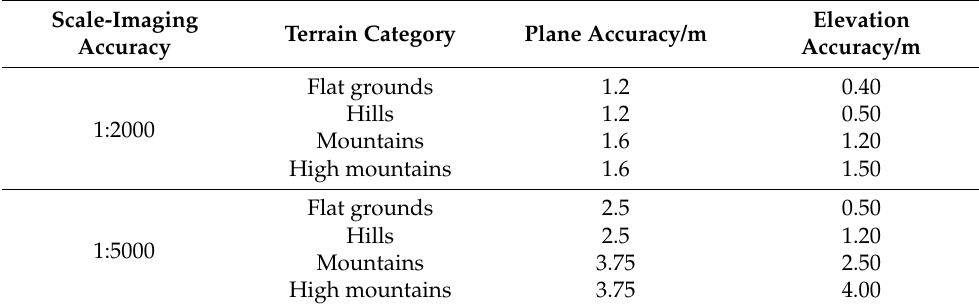
Table 3. Ground location accuracy of the airborne-mapping camera.